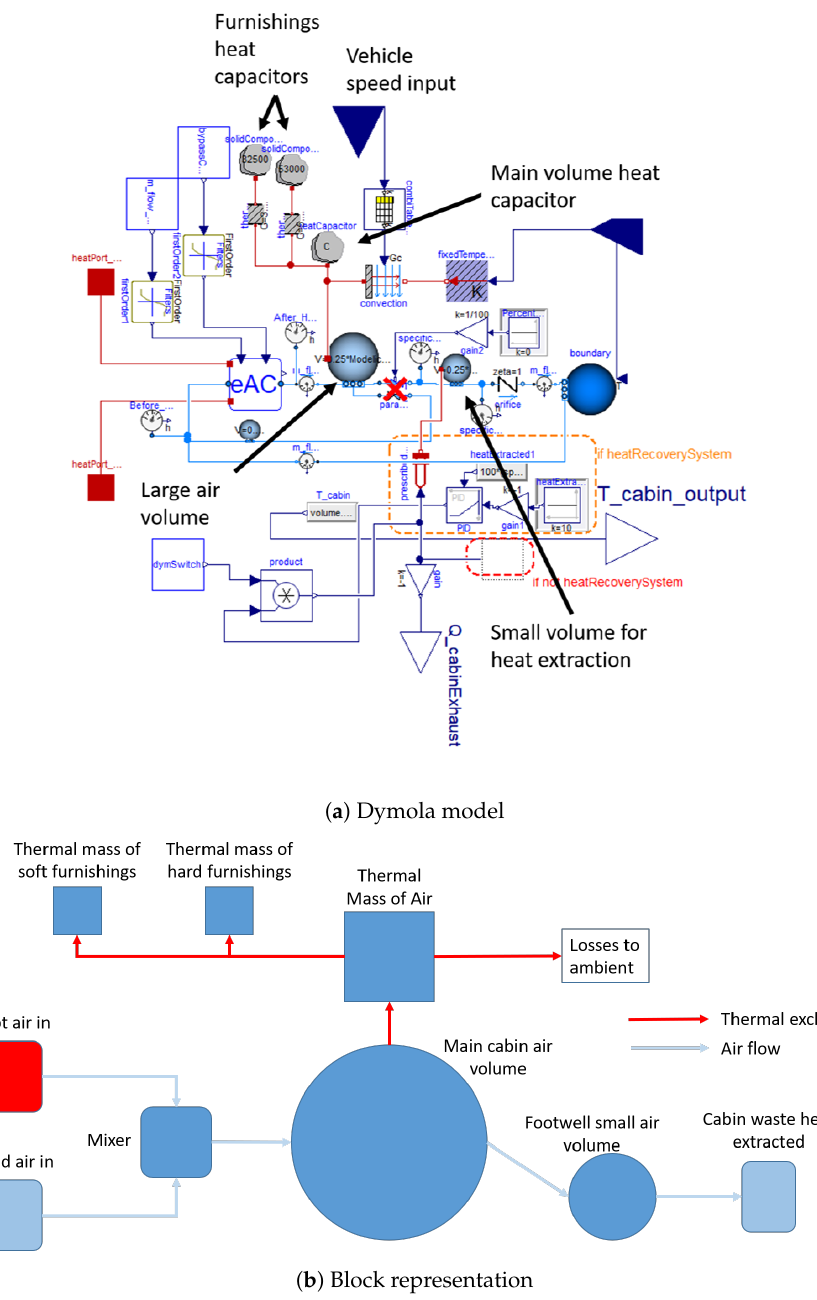
Figure 10. Here, the cabin model is shown both how it appears in Dymola, and a reduced block representation of its